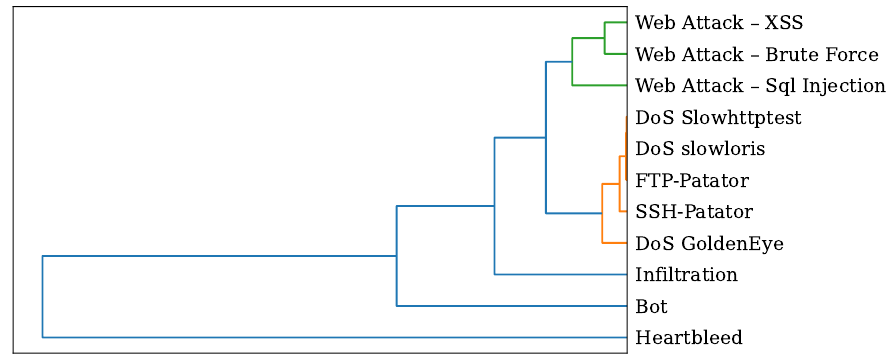
Figure 8. Hierarchical clustering of similarities between CICIDS2017 attack scenarios based on sig com